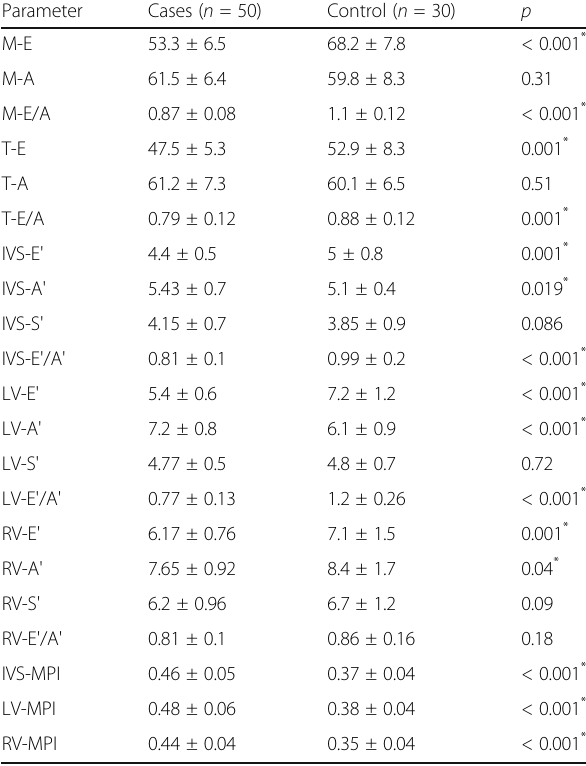
Table 1 Comparison between cases and control groups as regards PW Doppler, TDI, and TDI-based MPI